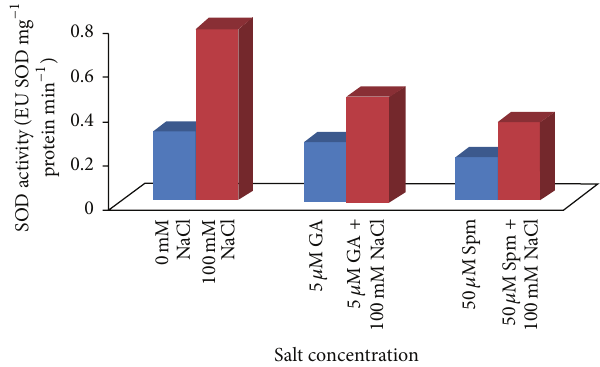
Figure 10: Effect of NaCl on the SOD activity of 10-day-old mungbean seedling and its possible amelioration with 5 𝜇 M GA 3 and 50 𝜇 M